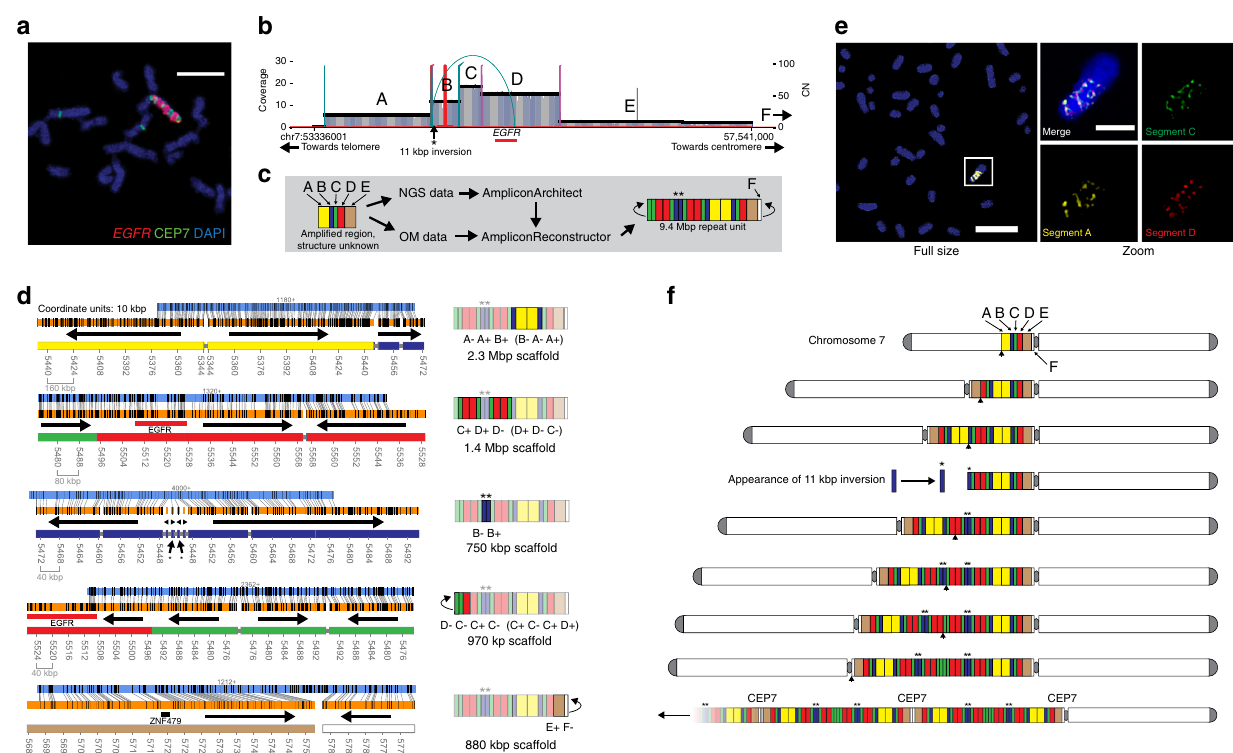
Fig. 4 Reconstruction of Breakage – Fusion – Bridge. a FISH confocal microscopy of DAPI-stained metaphase chromosomes in HCC827 showing multiple distinct bands of EGFR and CEP7 (chr7 centromeric repeat probe). Scale bar indicates 6 µ m. b AA-generated breakpoint graph for ampli fi ed EGFR region in HCC827. Asterisk ( ‘ * ’ ) symbol indicates presence of 11 kbp inversion at 5 ′ end of segment B. c Work fl ow for analysis of ampli fi ed EGFR region in HCC827 to reveal BFB repeat unit structure. Ampli fi ed intervals detected by AA are labeled A – E and are colored yellow, blue, green, red, and brown, respectively. Segment F indicates a region identi fi ed by AR but not AA. d Visualization of the AR-generated scaffolds (left column) and cartoon illustration of reconstructed region(s) of the BFB (right column), including segment sequence. Black arrows in the scaffold column indicate segment directionality. e Multi-FISH for BFB segments using super-resolution confocal microscopy on DAPI-stained metaphase chromosomes in HCC827. FISH probes used for segments A, C, and D were RP11-64M3, RP11-117I14, and EGFR , respectively. Scale for full size image indicates 11 µ m. Scale bar for zoomed images indicates 3 µ m. Brightness was decreased using ImageJ between full size and zoomed images. f Theoretical model of formation for HCC827 EGFR BFB. Each row indicates a pre fi x inversion and duplication characteristic of BFB, alongside other SVs. Black arrowheads beneath the intermediate step in each row indicates the breakpoint of the BFB chromosome. The bottom row shows multiple duplications of the BFB unit along with a pericentromeric region of chromosome region chr13:81120000 and non-amplicon region chr1:142890000 (Supplementary Fig. 14b). The second joined amplicon region chr13:93260000 and non-amplicon region chr1:142890000 (Sup-